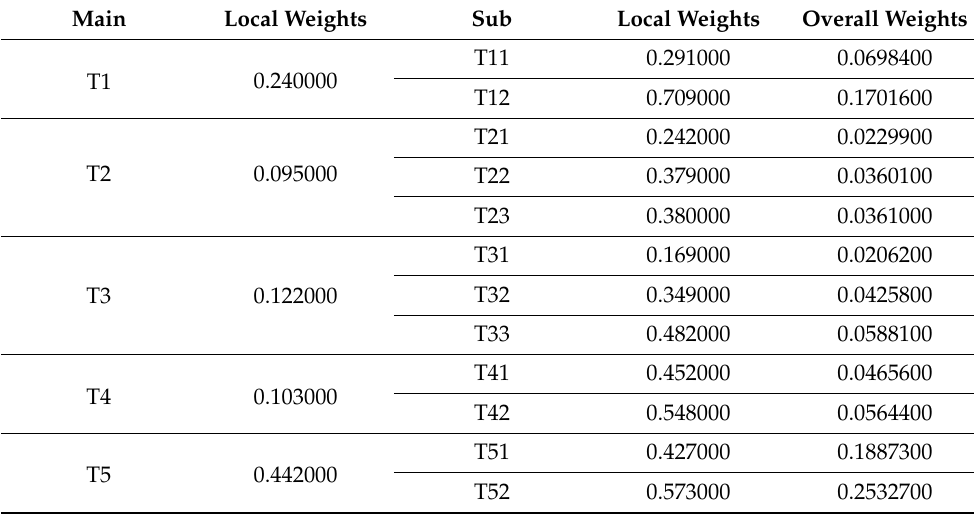
Table 13. Overall weights and ranking of methods.